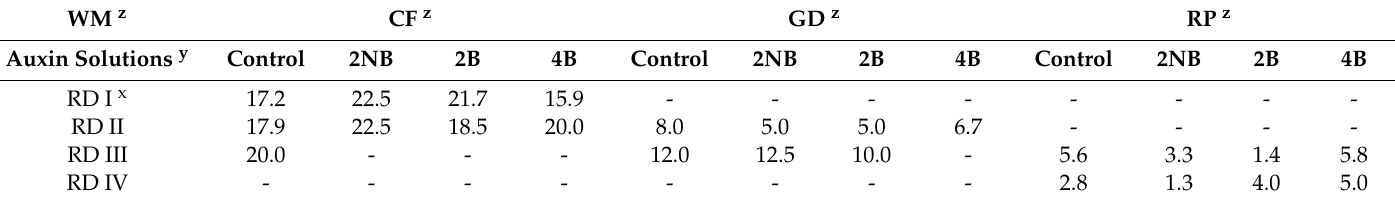
Table 4. The root length of wounding method (WM), root diameter (RD), and auxin solution treatment combinations on F. elastica heritage